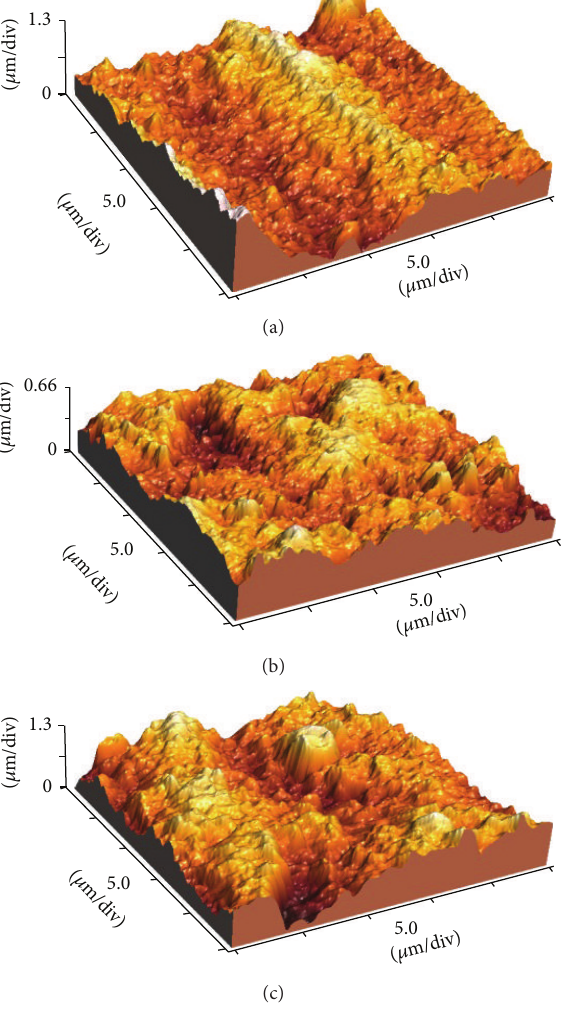
Figure 3: (a) AFM image for as-sintered zirconia surface. (b) AFM image of selective infiltration etched surface. (c) AFM image for fusion sputtered